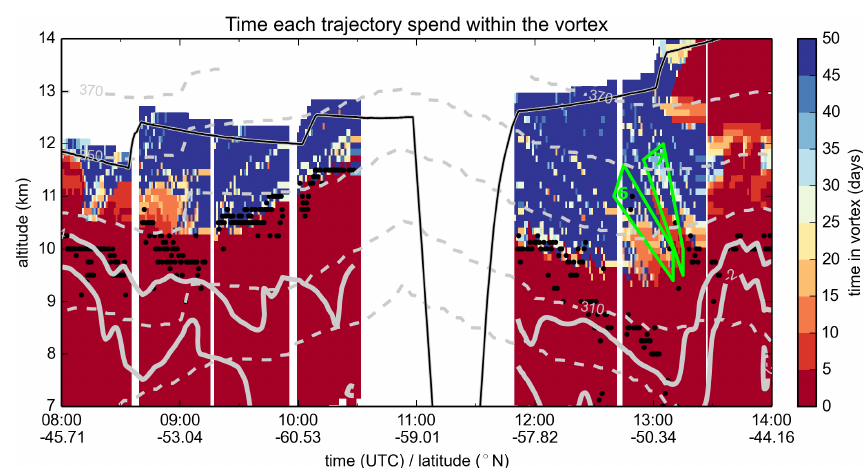
Figure 6. The time each GLORIA tangent point trajectory has spent in the vortex before the measurement. The green boxes mark two of the filaments (6, 7) observed by GLORIA (see Fig. 4). The flight path, tropopause height, potential temperature, and PV isolines are the same as in Fig.